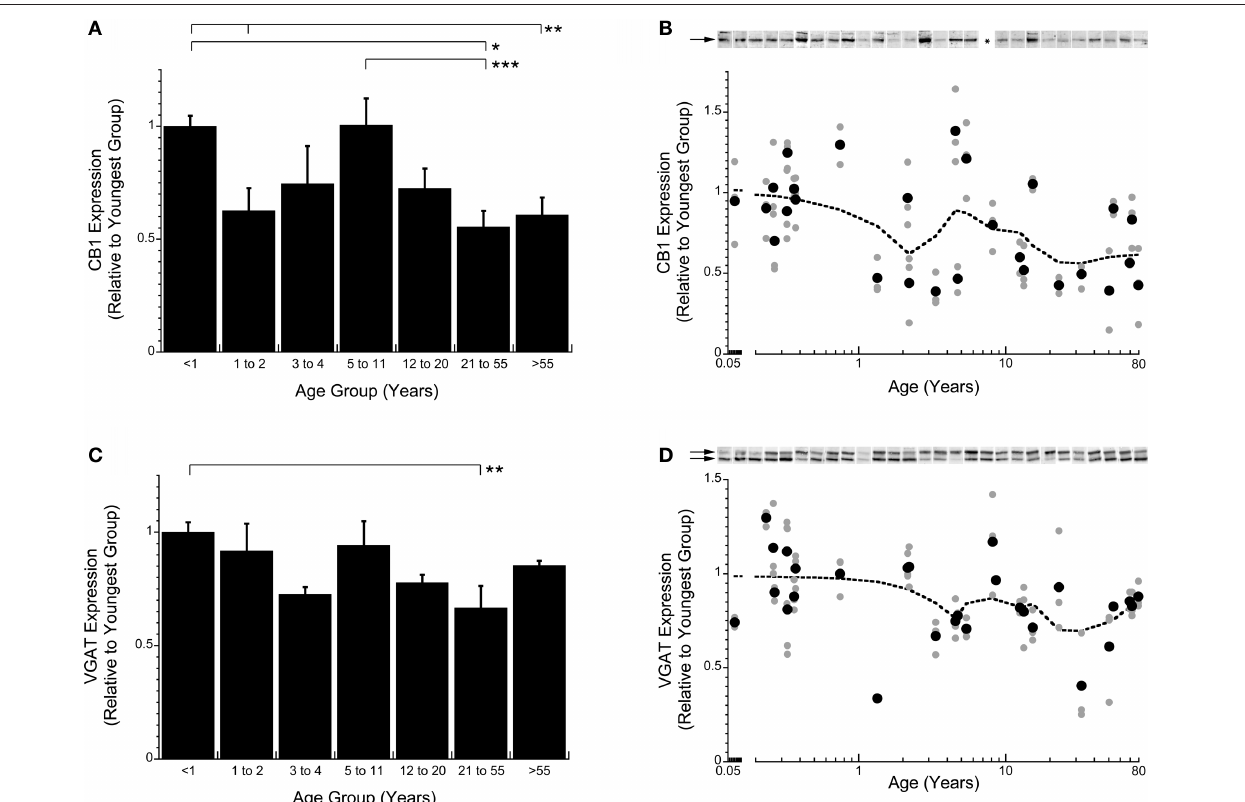
FiGure 2 | Quantification of changes in expression levels of CB1 (A,B) and VGAT (C,D) in human visual cortex across the lifespan. The graphs follow the same conventions as described in Figure 1 . CB1 levels are high in infants ( < 1 year) then fall into young children (1–2 years) before rising again in pre-teens (5–11 years) and falling again in teens (12–20 years) and leveling off (Kruskal–Wallis, p < 0.0001) (A,B) . For VGAT 2 bands were quantified (arrows at 50 and 57 kDa). VGAT levels are